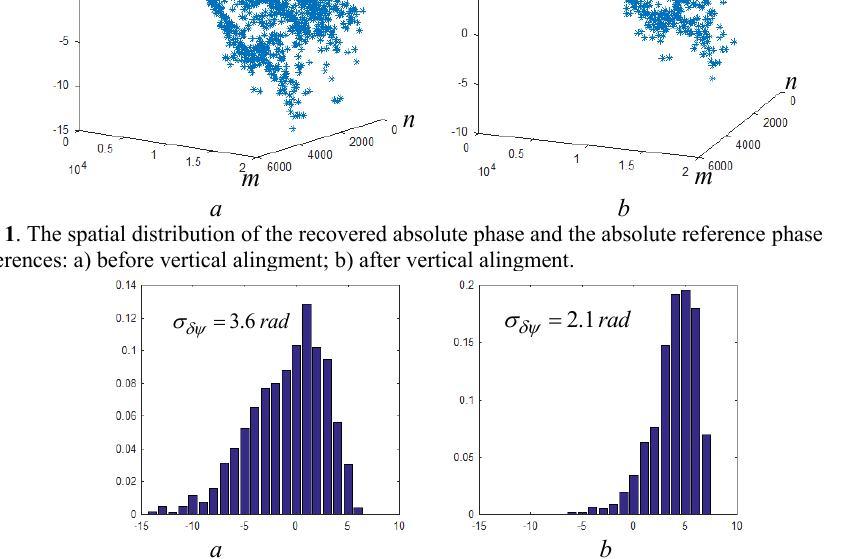
Fig. 2 . Histograms of the recovered absolute phase and the absolute reference phase differences: a) before vertical alingment; b) after vertical